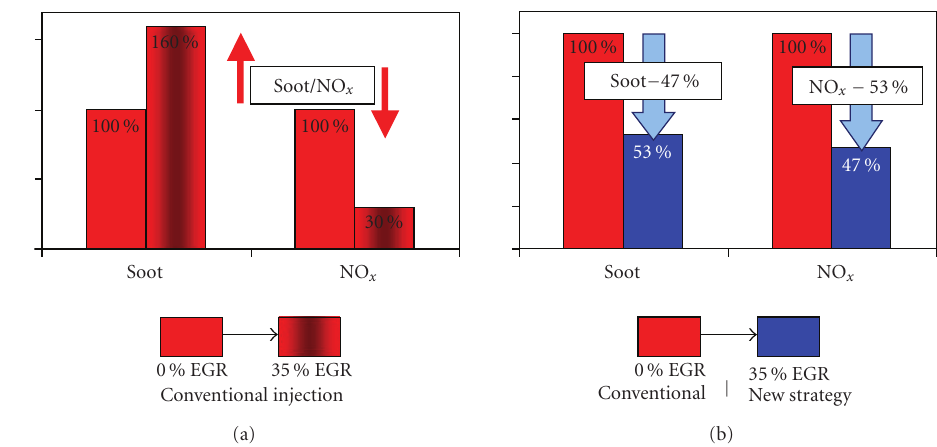
Figure 8: Potential for simultaneous soot and NO x reduction.